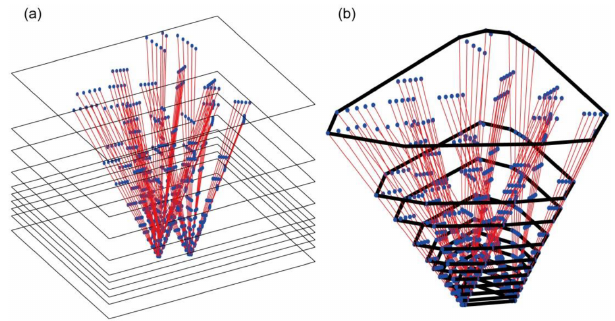
Figure 3. (a) A tomographic field is divided by many layers, the thickness of which is dependent upon the distribution of water va- por in the layer, the red lines are the sampling GNSS signals and the blue points are the intersections of the GNSS signals on each horizontal plane; and (b) tomographic boundary is depicted by the black polygon on each horizontal